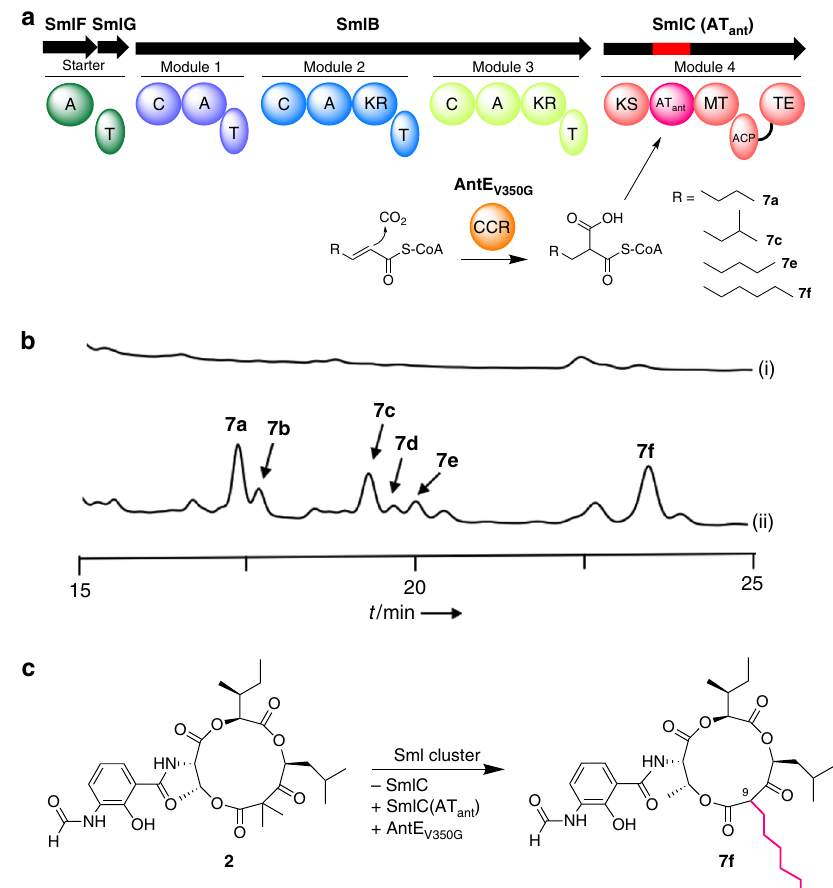
Fig. 5 Alkyl chain diversi fi cation of JBIR-06. a The reconstituted module structure for alkyl chain diversi fi cation. b HPLC analysis of the metabolites from transformants harboring (i) pKU518J06 and (ii) pKU518J06 Δ SmlC/pZH2-SmlCAT ant -AntEV350G. The chromatogram represents the UV absorbance at 320 nm. c Engineering scheme and structure of the representative product